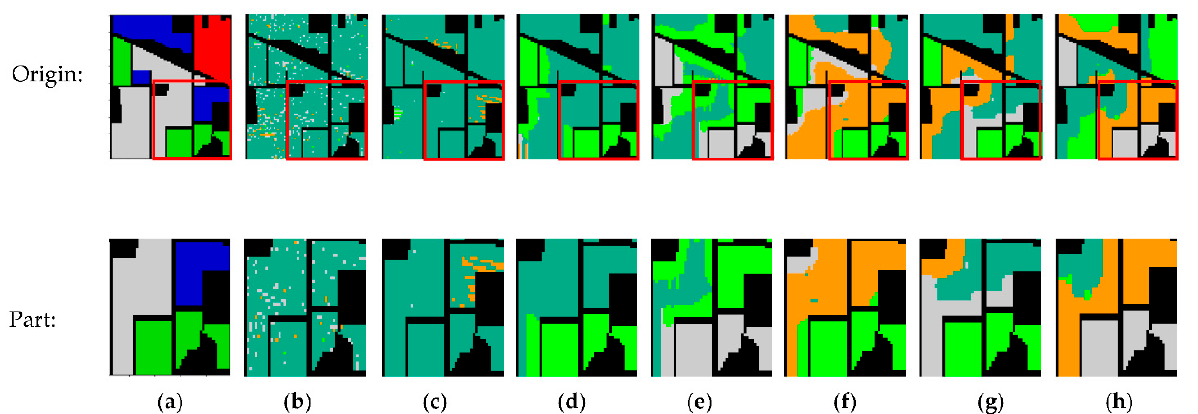
Figure 6. Clustering results obtained using different methods on the SalinasA data set with salt and pepper noise. ( a ) Ground truth. ( b ) LRSC 43.49%. ( c ) SSC 48.60%. ( d ) S4C 51.08%. ( e ) EDSC 61.03%.